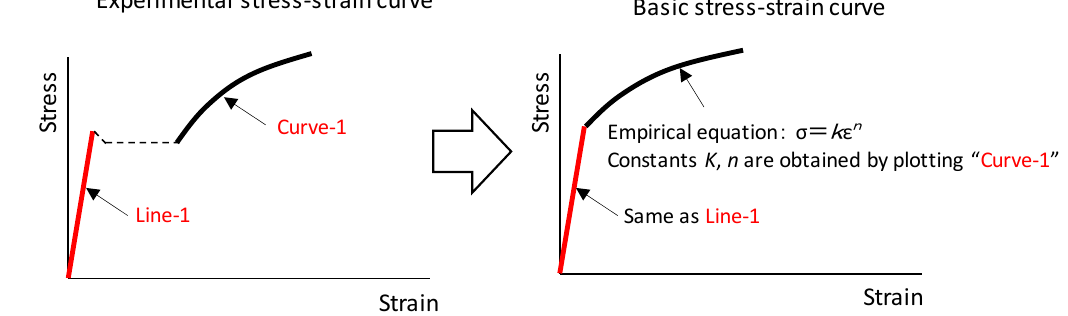
Figure 3. Schematic representation of a basic stress-strain curve [4].